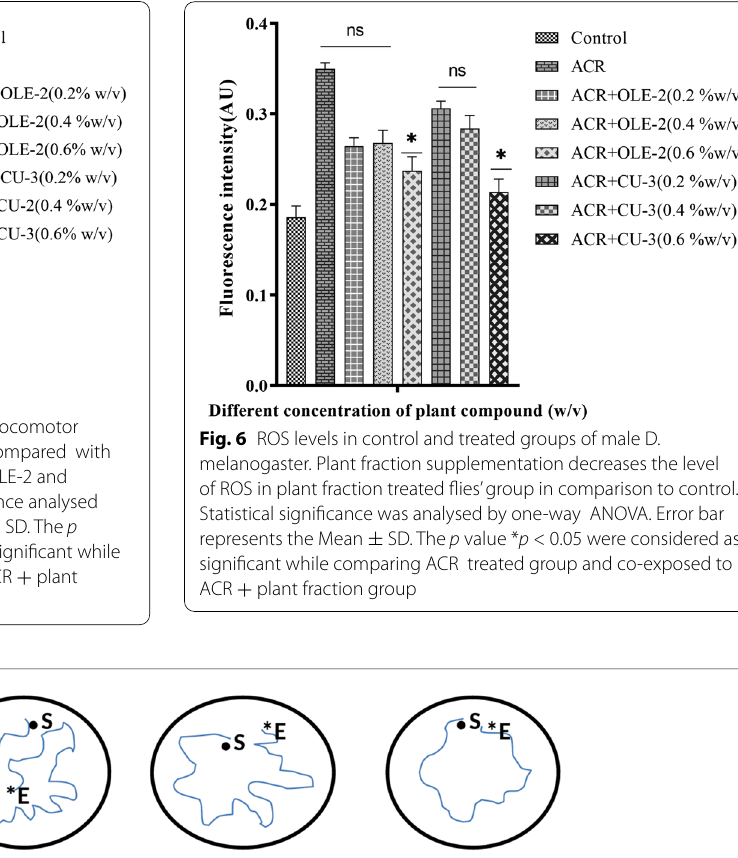
Fig. 5 Moving behaviour control and ACR and ACR fraction groups showed less irregular movement. ‘S’ is the starting point of fly, ‘E’ is theendpoint of fly